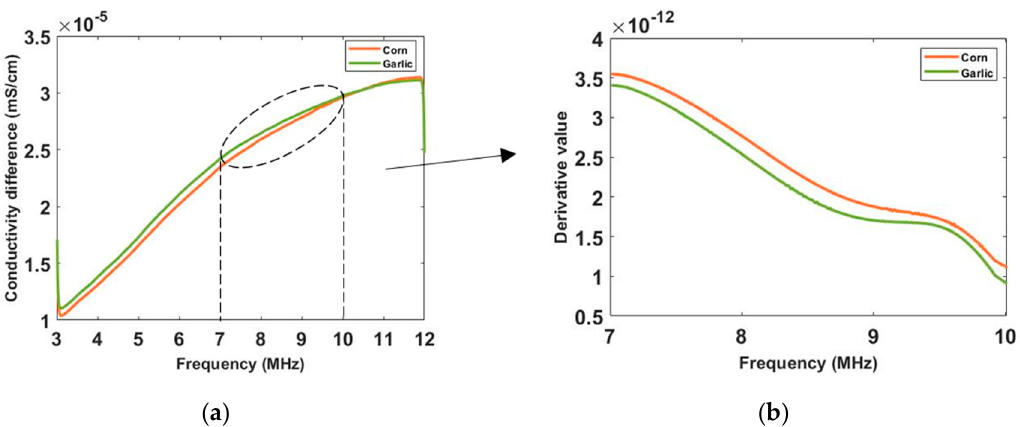
Figure 11. ( a ) Reconstructed conductivity spectra for corn and garlic with multifrequency circular CCERT. ( b ) Deriviate of conductivity with repect to frequency.